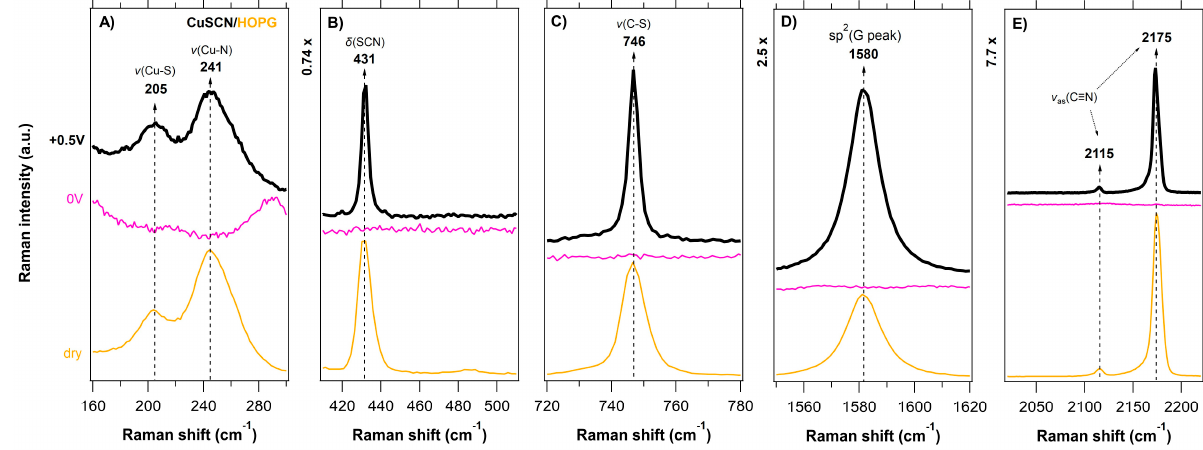
Figure 6. In situ Raman- µ SEC spectra of the CuSCN layer (spectral regions of 160–300, 410–510, 720–780, and 2020–2220 cm –1 in charts ( A – C , E ), respectively) electrodeposited on the HOPG substrate (spectral region of 1550–1620 cm –1 in chart ( D ) as a function of the applied potential (vs. Ag/AgCl; shown on the left-side chart) in 6 M LiCl. The measurement sequence was as follows; the first spectrum was acquired at 0 V (pink trace) and the last spectrum was acquired at +0.5 V (top black trace). The reference (ex situ) Raman spectrum of dry CuSCN layer on the HOPG substrate is shown for comparison (bottom yellow trace). Spectra are offset for clarity; the intensity scale is identical for all the charts.